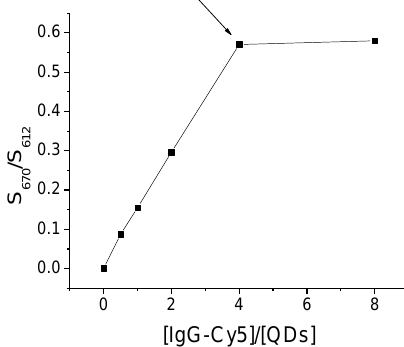
Figure 2. S / S increases with increasing [IgG-Cy5]/[QDs] ratio. S 670 612 integrated signal intensity at 670 nm (acceptor channel) and 612 nm (donor channel), respectively. CE conditions: 25 mM borate buffer (pH 9.3) at 18 kV. λ [QDs] = 2